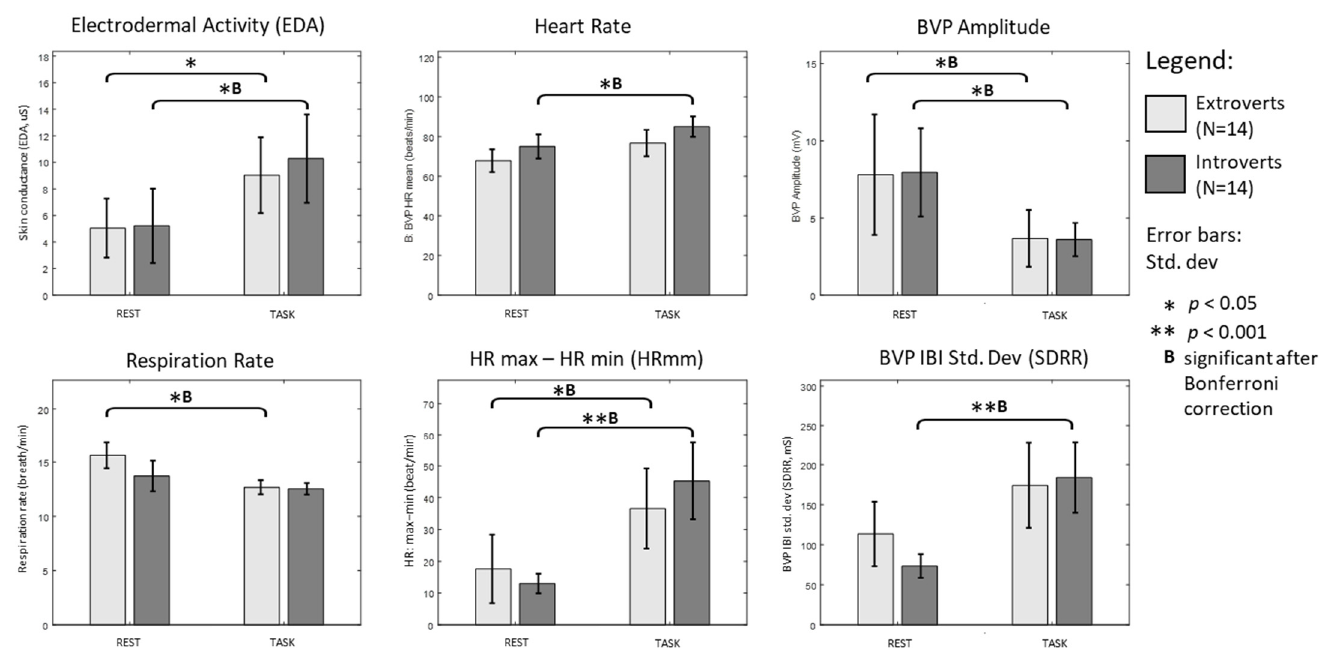
Figure 2. Physiological markers during speech task (TASK) were significantly different as compared to baseline (REST).